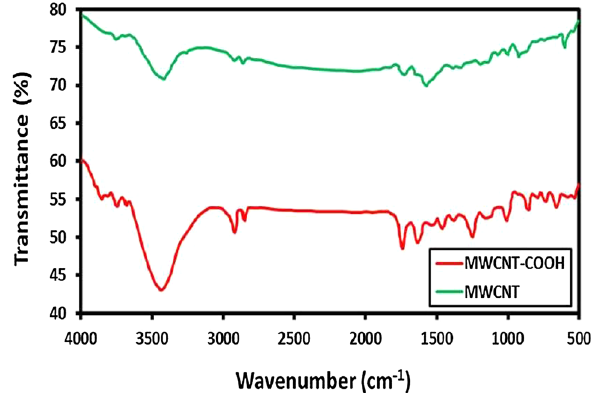
Fig. 2 FTIR image of MWCNT and MWCNT–COOH